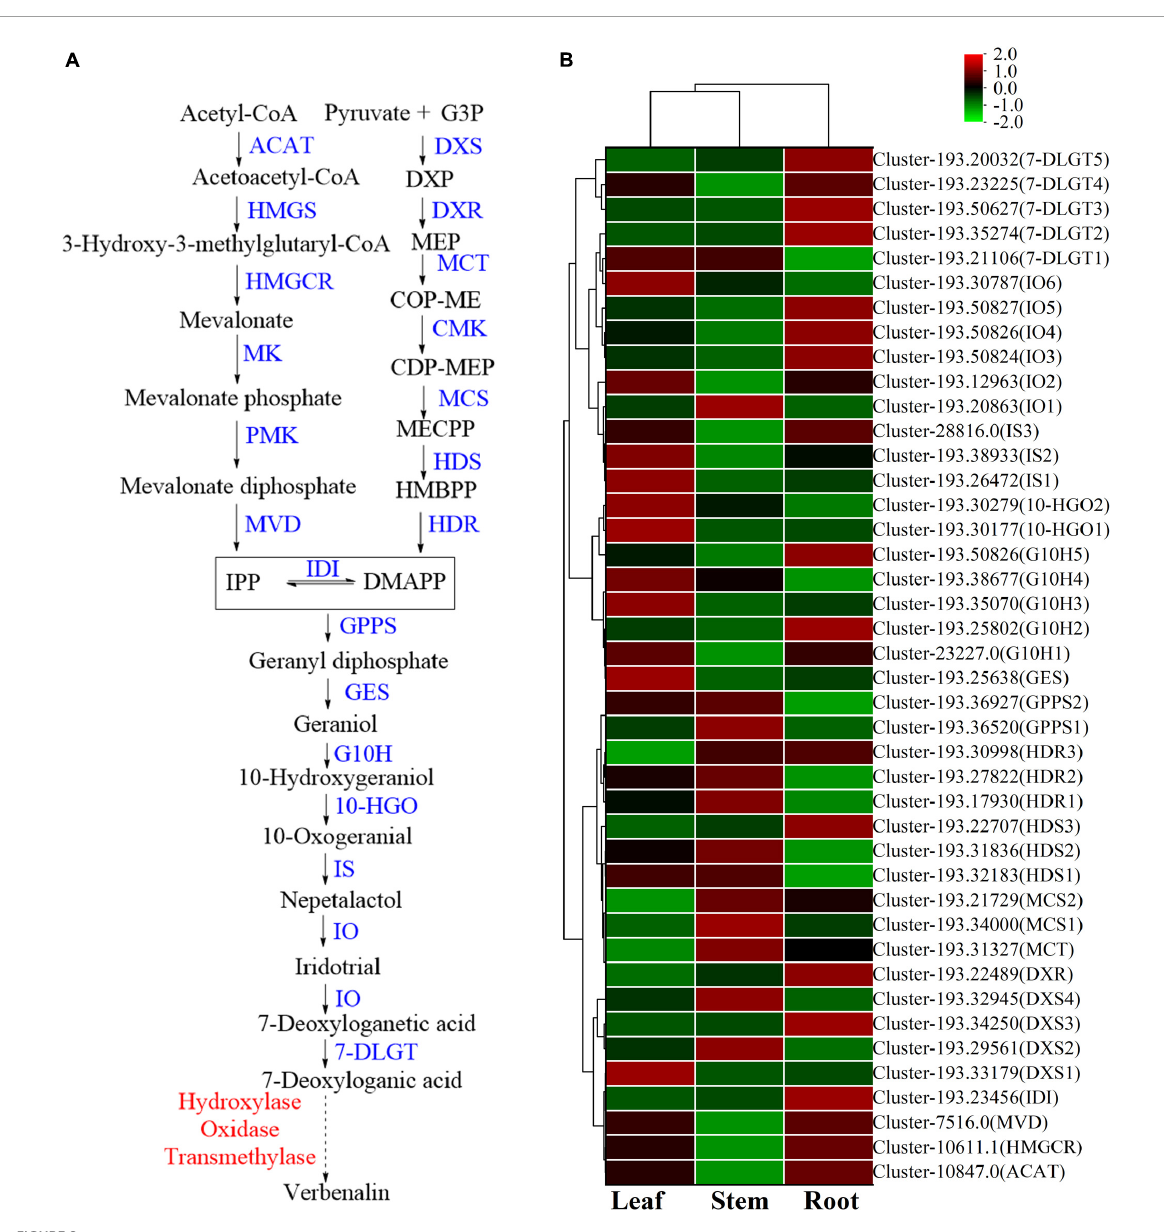
FIGURE8 The iridoid glycosides biosynthesis pathway and the heatmap of corresponding genes in Verbena officinalis . (A) Predicted biosynthetic pathways of iridoid glycosides. Compounds are in black, enzyme names are in blue, and the red have not been reported. The solid arrows are the processes that have been reported, and the dashed lines have not been reported. (B) Heatmap of iridoid glycosides pathway